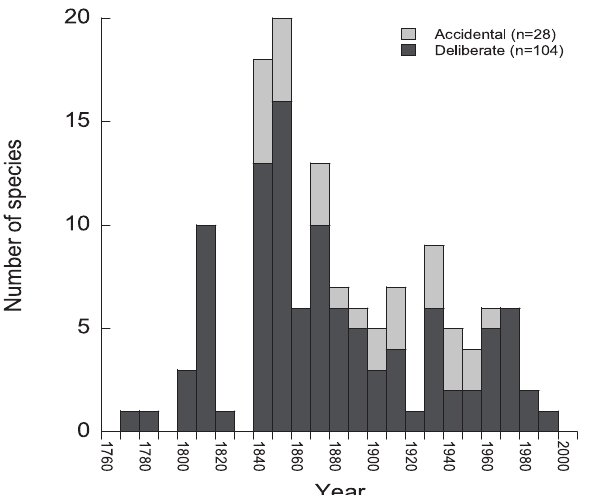
Figure 1. Frequency distribution of introduction times of invasive alien plant species in Australia in relation to method of introduction (accidental or